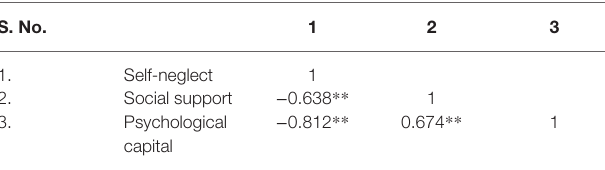
TABLE 2 | The correlation between self-neglect, social support, and psychological capital. S.